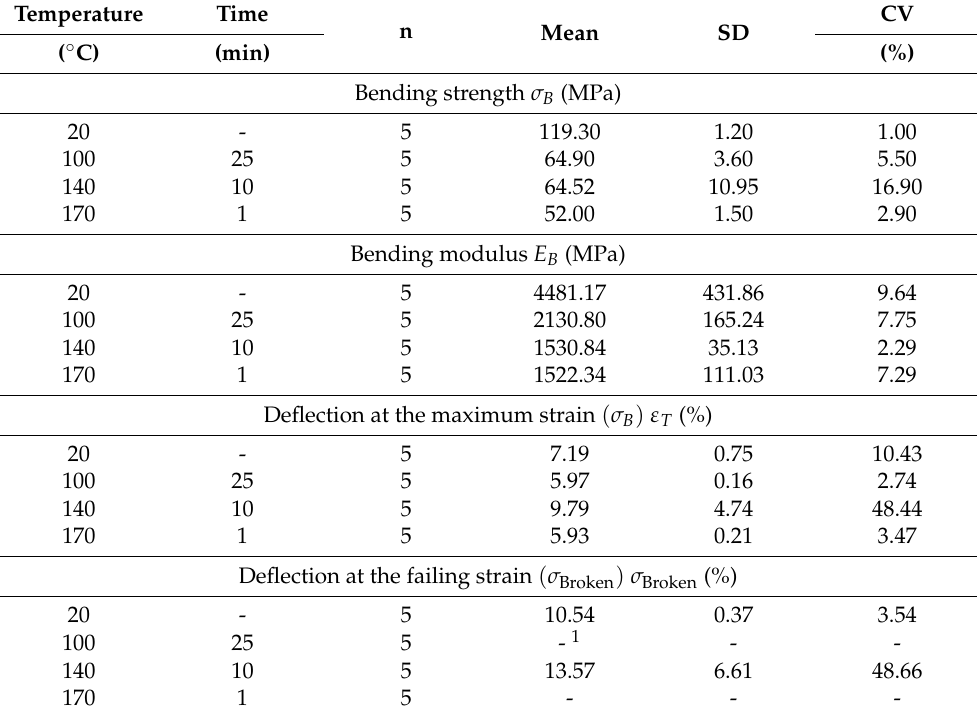
Table 4. Descriptive statistics of results of composite bending strength test after being treated with the hot airflow.